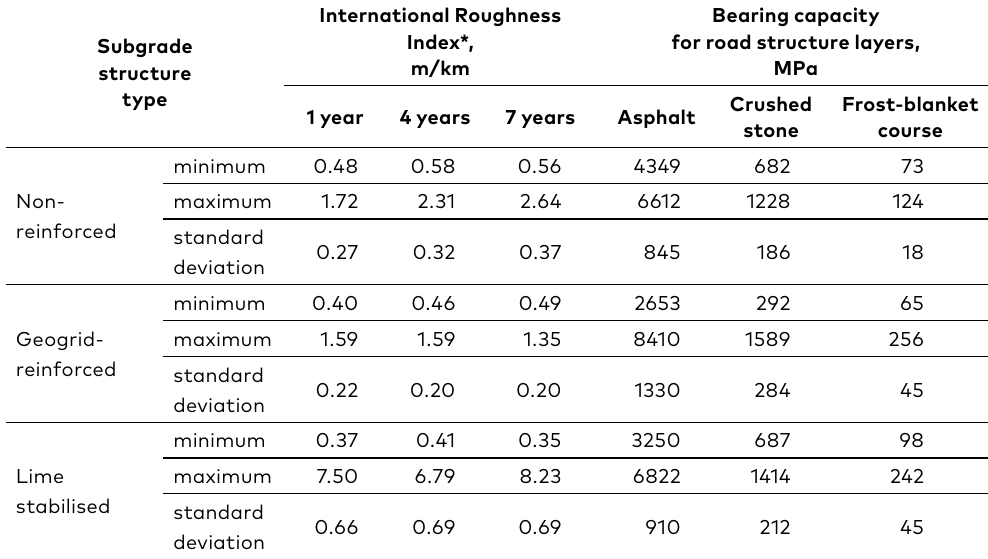
Table 2. Statistical values by the type of subgrade structure of